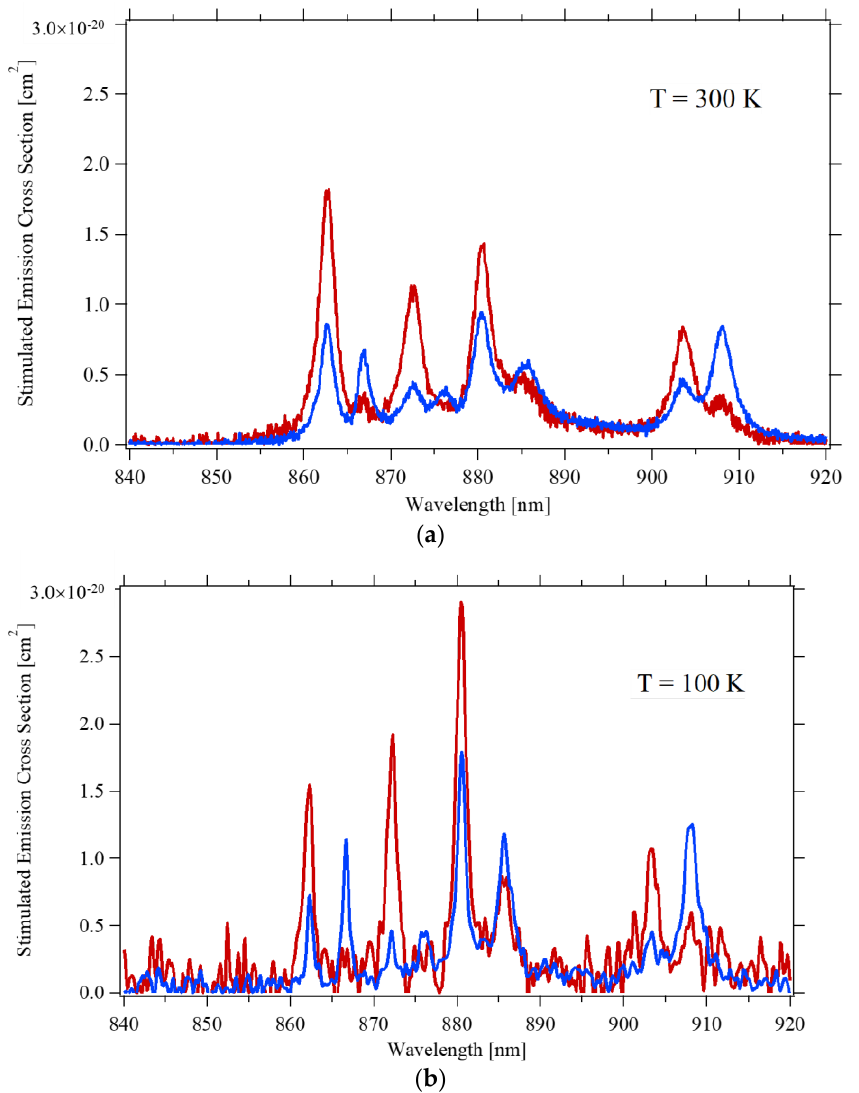
Figure 8. Emission cross-section of the 4 F 3/2 → the 4 I 9/2 transition for π –polarized (Red) and σ –polarized (Blue) light, at two temperatures: ( a ) T = 300 K; ( b ) T = 100